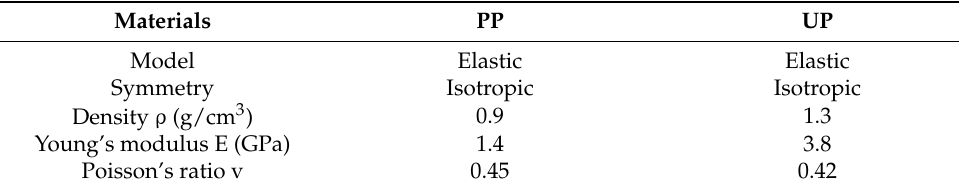
Table 3. Mechanical properties of polymers.